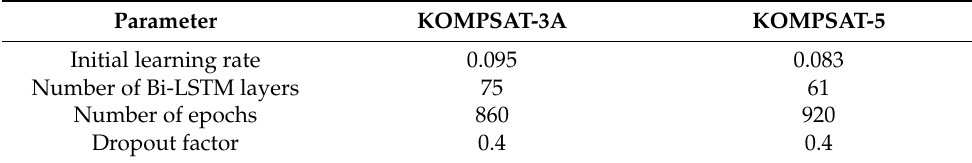
Table 1 lists the parameters used for the Bi-LSTM network training. Table 1. Parameters of the Bi-LSTM